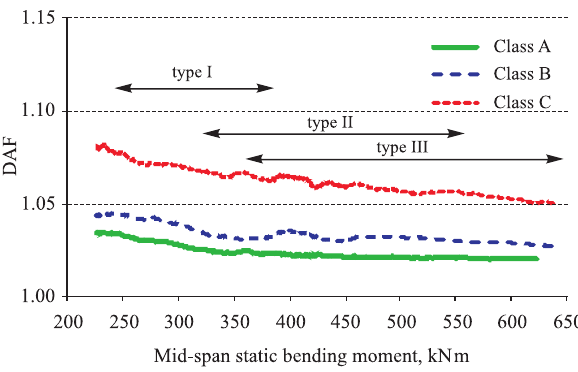
Fig. 9. Average DAF values for meeting events over 25m span bridge without bump. Arrows indicate the range where specified meeting event types